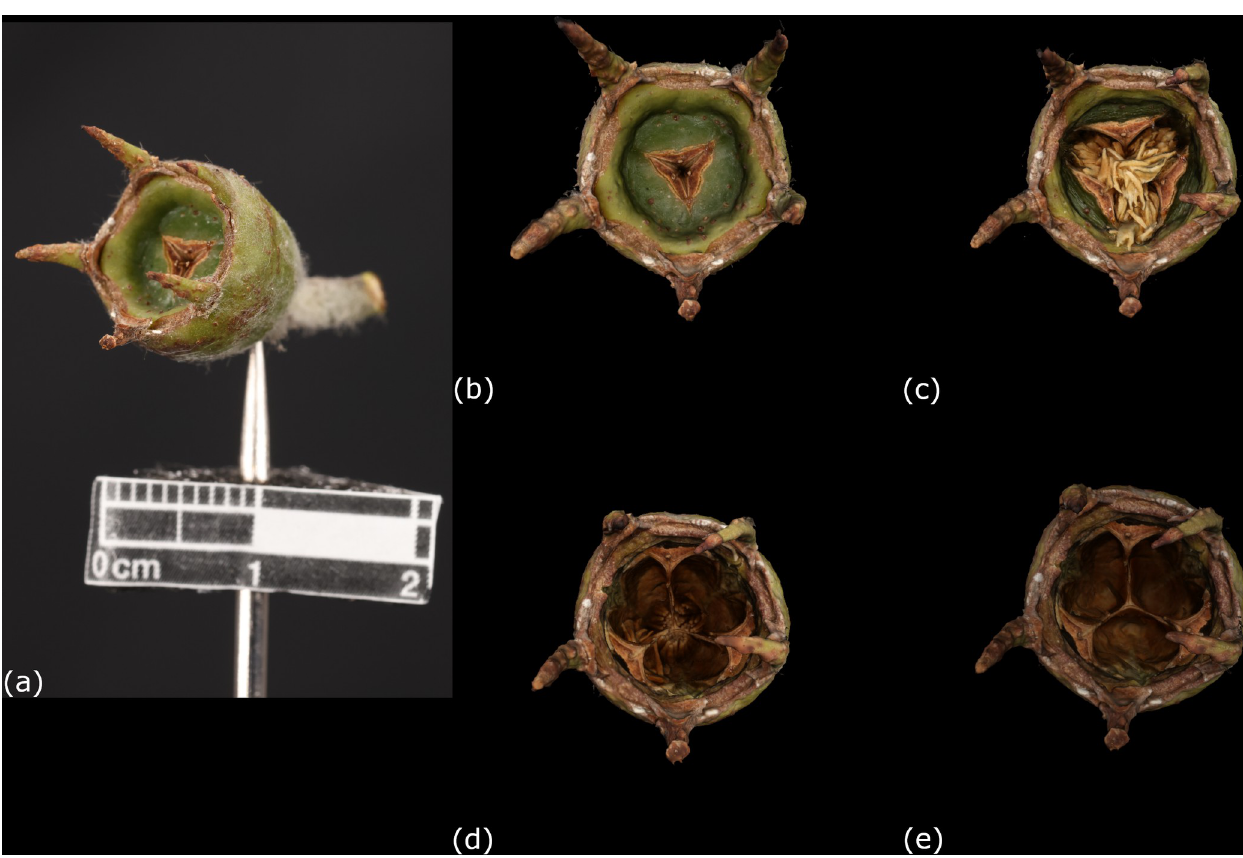
Fig 11. 3D models of Lophostemon confertus (R. Brown) Peter G. Wilson & J. T. Waterhouse at different time points after collection. (a) A carpological material of the fruit of L . confertus was fixed for image capturing. (b) Top view of the 3D model (PH054) reconstructed on day 1. The valves on top of the fruit were closed. (c) Top view of the 3D model (PH054) reconstructed on day 2. The valves of the capsule started to retreat, and the seeds inside were exposed. Two sepals contracted and bended inwards. (d) Top view of the 3D model (PH054) reconstructed on day 5. Most of the seeds had fallen and the internal structure of the capsule was clearly seen. (e) Top view of the 3D model (PH054) reconstructed on day 10. All the seeds were released.